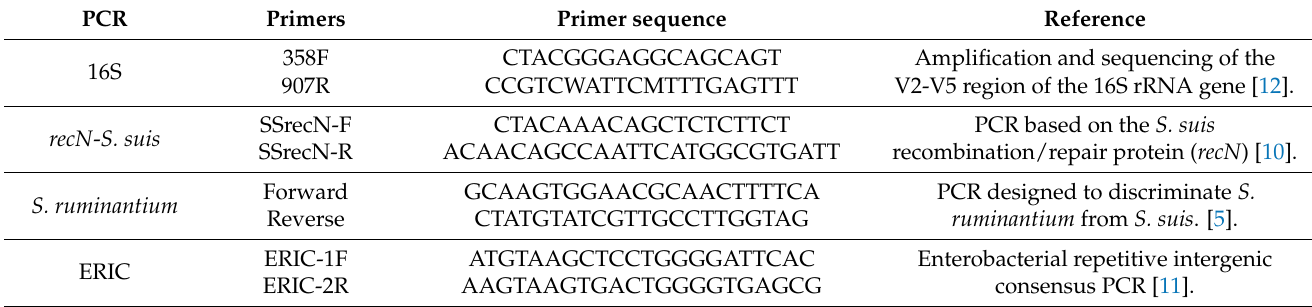
Table 2. Primers used for bacteria